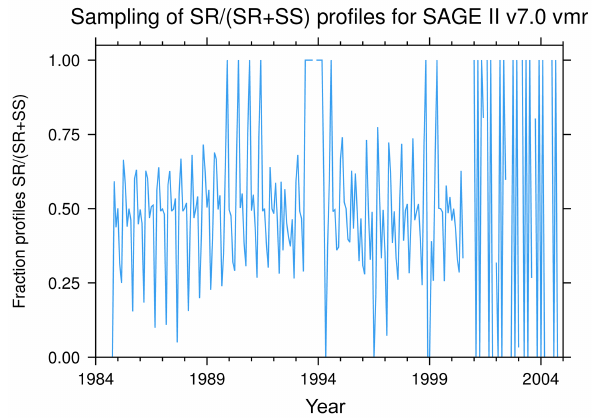
Figure 2. Time series of the fraction of sunrise to total (sun- rise + sunset) profiles used to generate monthly mean ozone val- ues in the tropics (30 ◦ S–30 ◦ N) at 1hPa for the SAGE II v7.0 vmr